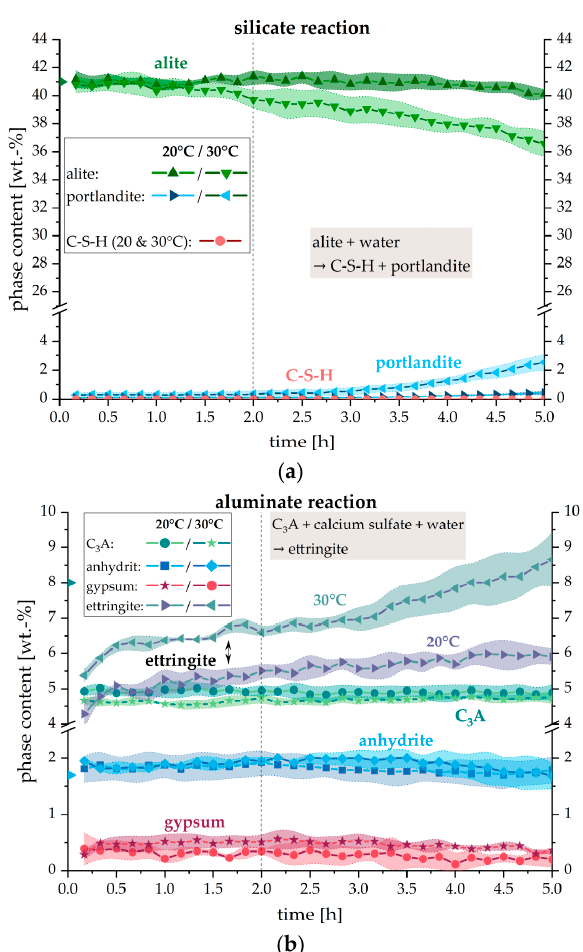
Figure 2. Phase development with respect to ( a ) the silicate and ( b ) the aluminate reaction of CEM I during hydration within five hours after contact with water at 20 °C and 30 °C (w/c = 0.36). Colored background indicates the error of 3 independent measurements. Expected values at the time of mixing: alite = 41.0 wt. %, C 3 A = 8.0 wt. % and anhydrite = 1.7 wt. % (triangles at t = 0 h).